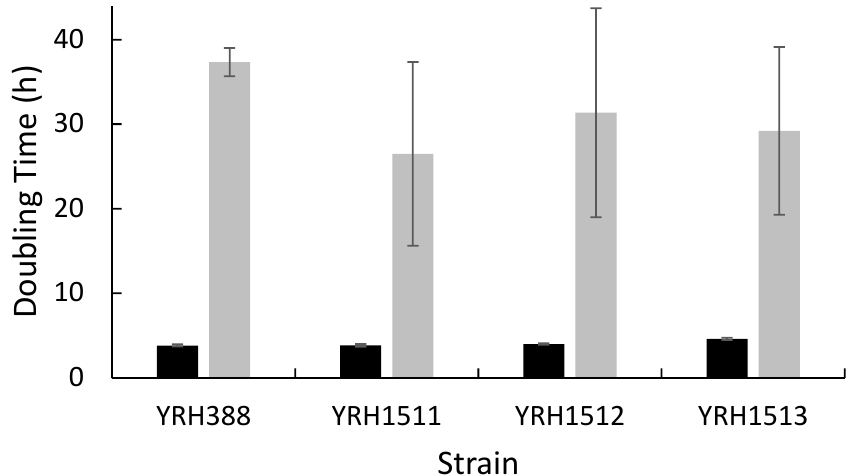
Figure 4. Growth of S. cerevisiae YRH388 and mutants in recycled switchgrass hydrolysate. Black bars: early growth stage; gray bars: late growth stage. Error bars indicate standard deviation for one experiment carried out with four replicates. After hydrolysate was recycled four times (see text), the hydrolysate contained 0.008% ( w / v ) glucose and 0.66% ( w / v ) xylose. Inhibitors were 0.08 M HMF and 0.09 mM furfural. 1 g / L yeast extract and 2 g / L peptone were added prior to this growth assay.